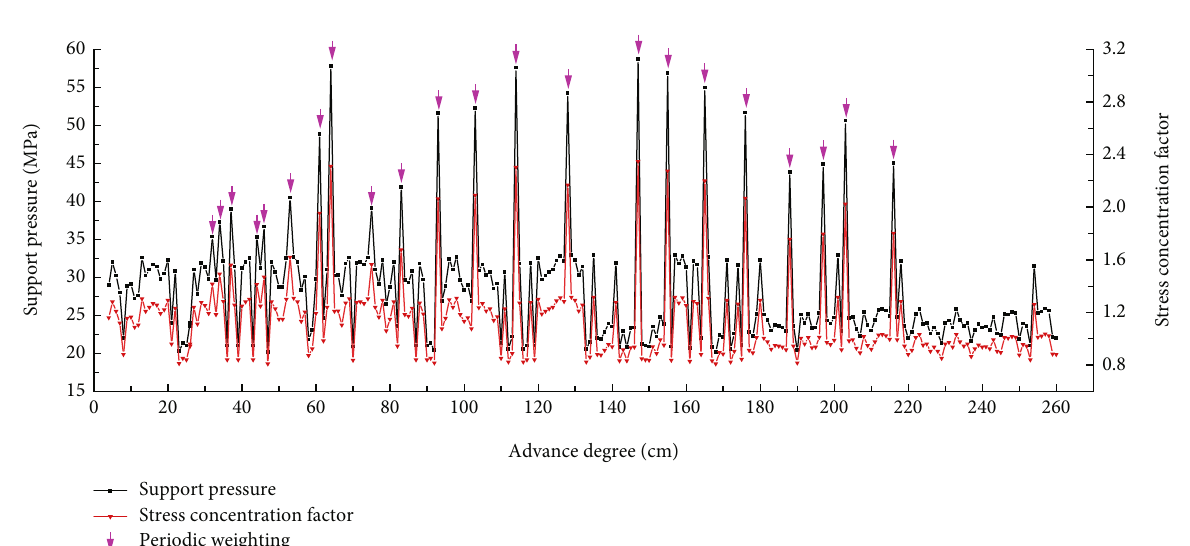
Figure 19: Support pressure and stress concentration coe ffi cient in the 222 working